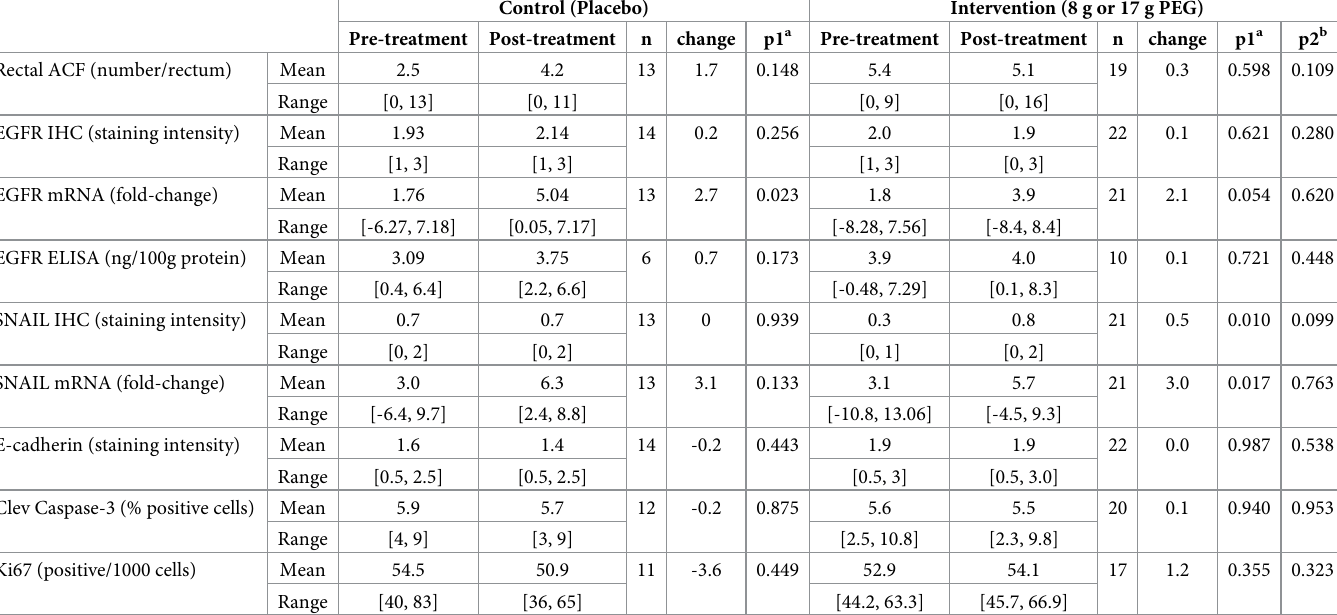
Table 2. Changes in mean values of biomarkers in treated and placebo groups, with high and low PEG doses